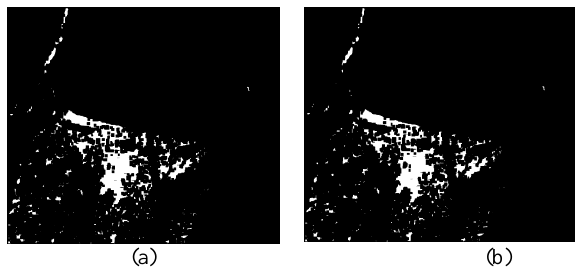
Table 4. Image statistics results of the post-processing